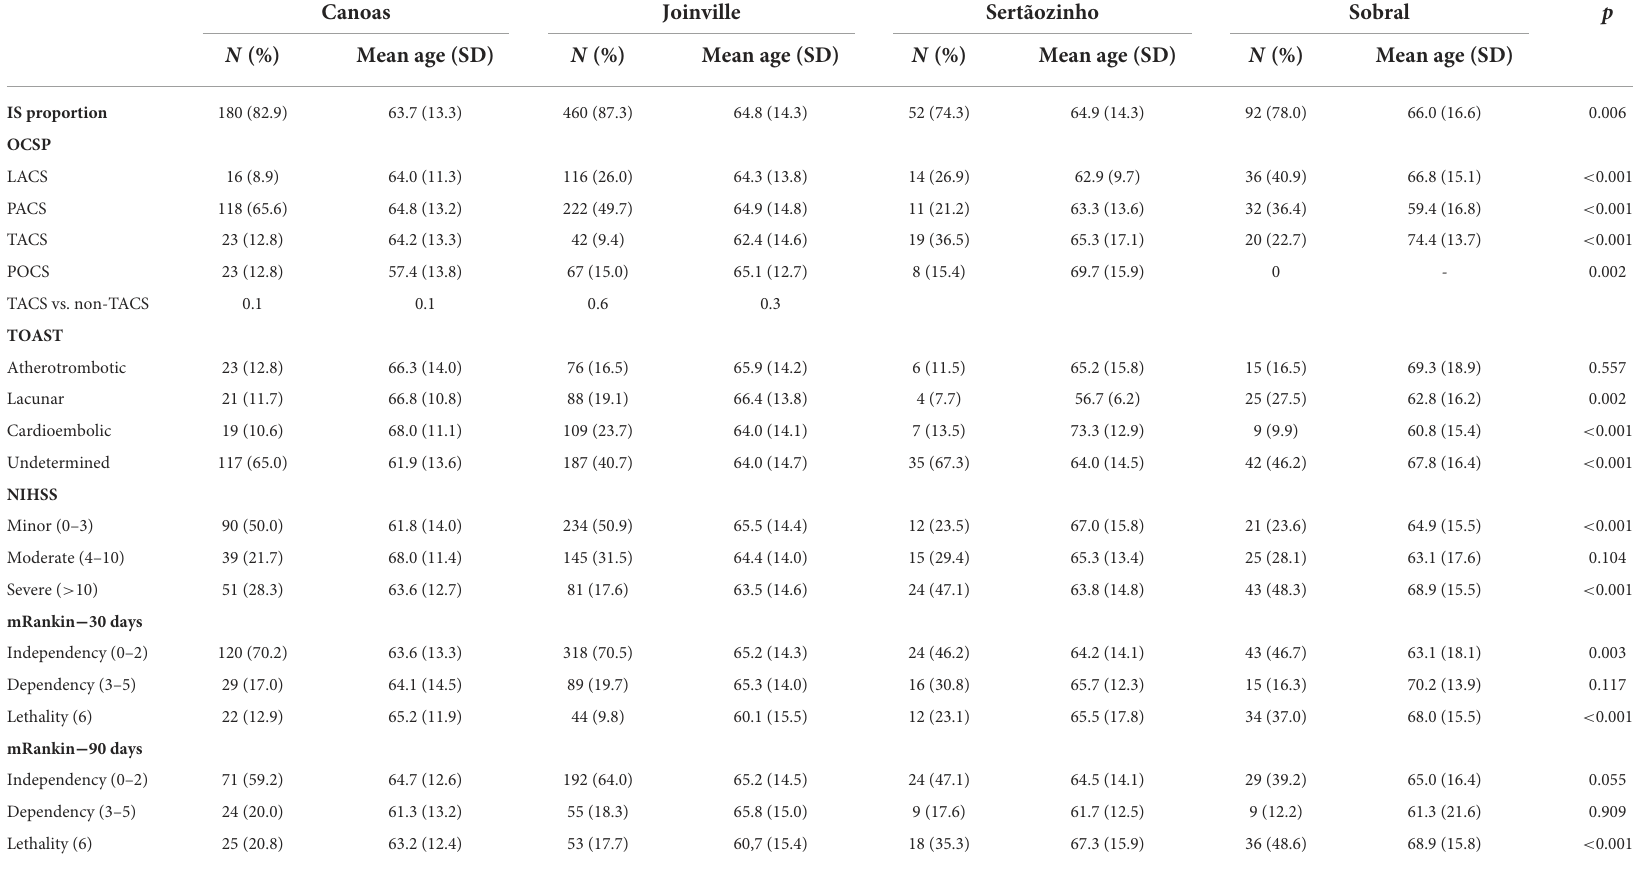
TABLE 4 Ischemic stroke cases and outcomes in one and 3 months after